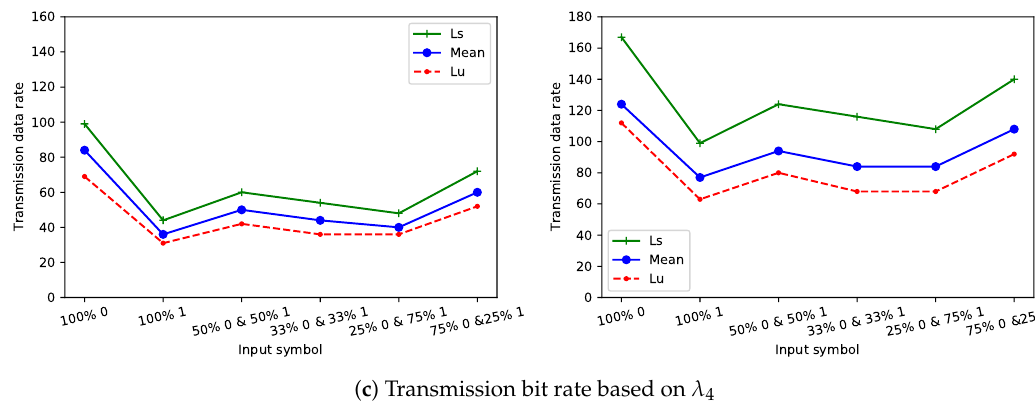
Figure 5. Transmitted bit rates of network configuration 1 (left) and network configuration 2